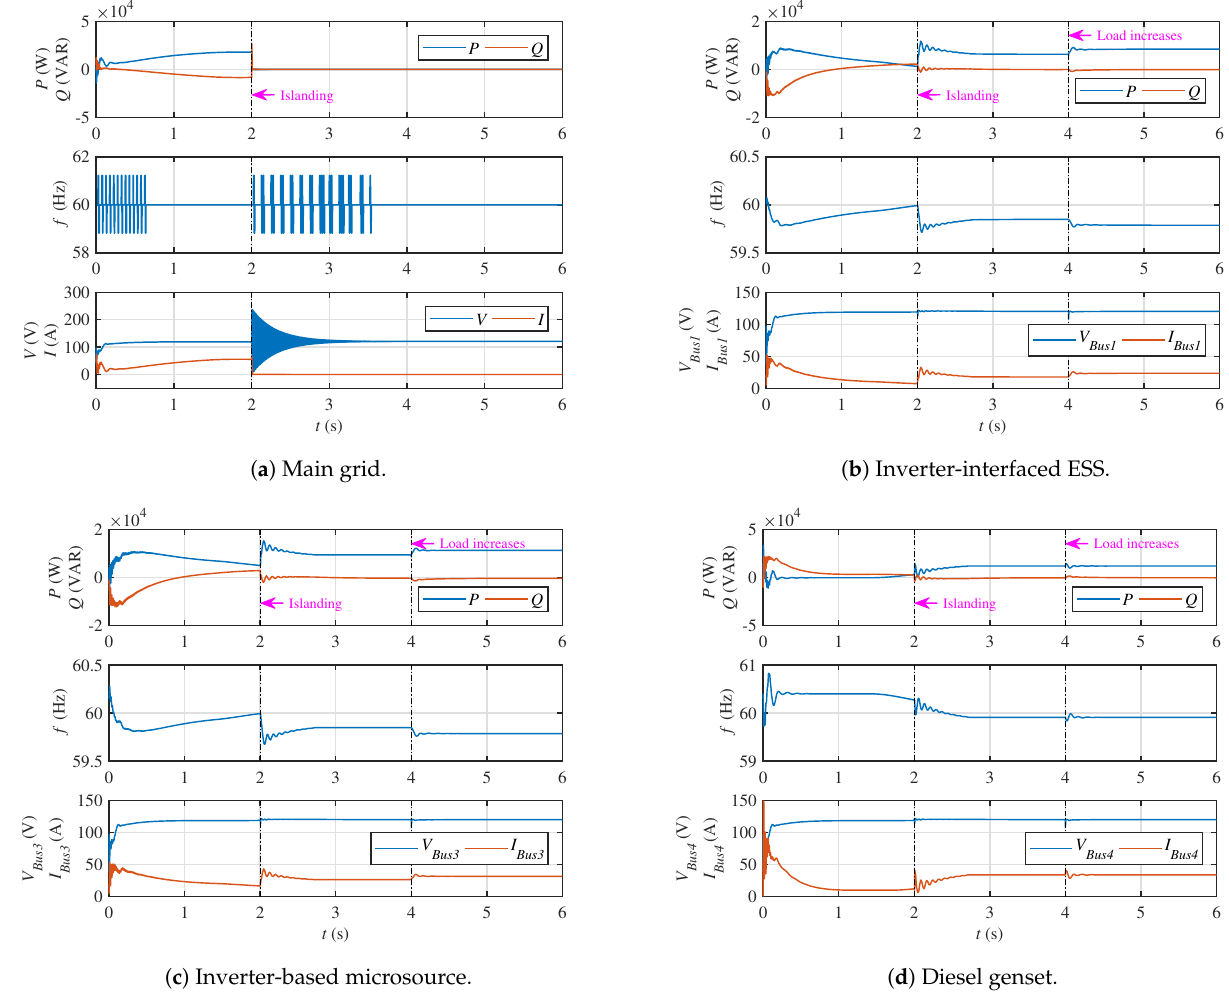
Figure 6. The main grid and DG units performance under droop/primary control alone. In the case of several DG units operating in parallel in an MG, the bus voltage reg- ulation to a specific value causes reactive power to circulate between the DG units. This phenomenon enhances the DG units’ rating and reduces the efficiency of the system. To mitigate this problem, a QV -droop strategy was adopted [52]. As depicted in Figure 6, the circulating reactive powers were easily observable prior to the islanding event at t = 2 s. However, once all the bus voltages were regulated (to V req = 120 V line-to-neutral or 208 V phase-to-phase), after the islanding event, the circulating reactive powers between